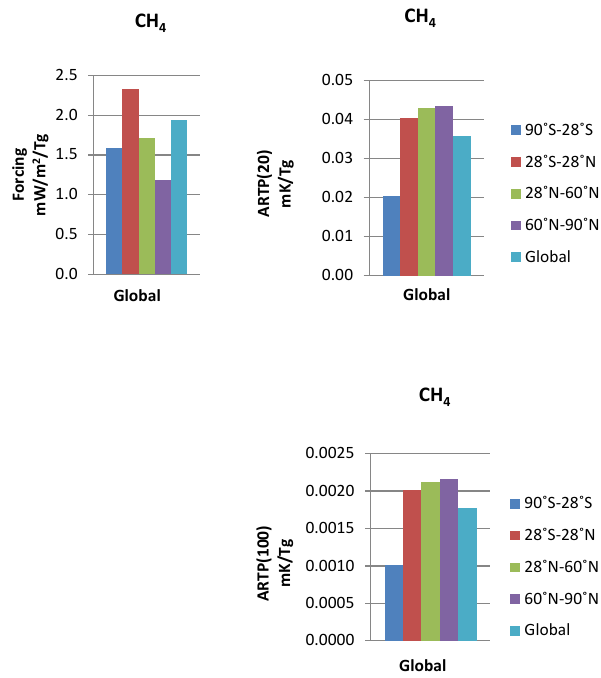
Fig. 6. Normalised equilibrium forcing in mWm 2 Tg − 1 (left), and ARTPs 20 and 100 (right), for global emissions of CH 4 . The coloured columns represent the forcing and temperature responses in 4 different latitude bands (90 ◦ S–28 ◦ S, 28 ◦ S–28 ◦ N, 28 ◦ N– 60 ◦ N, 60 ◦ N–90 ◦ N) and